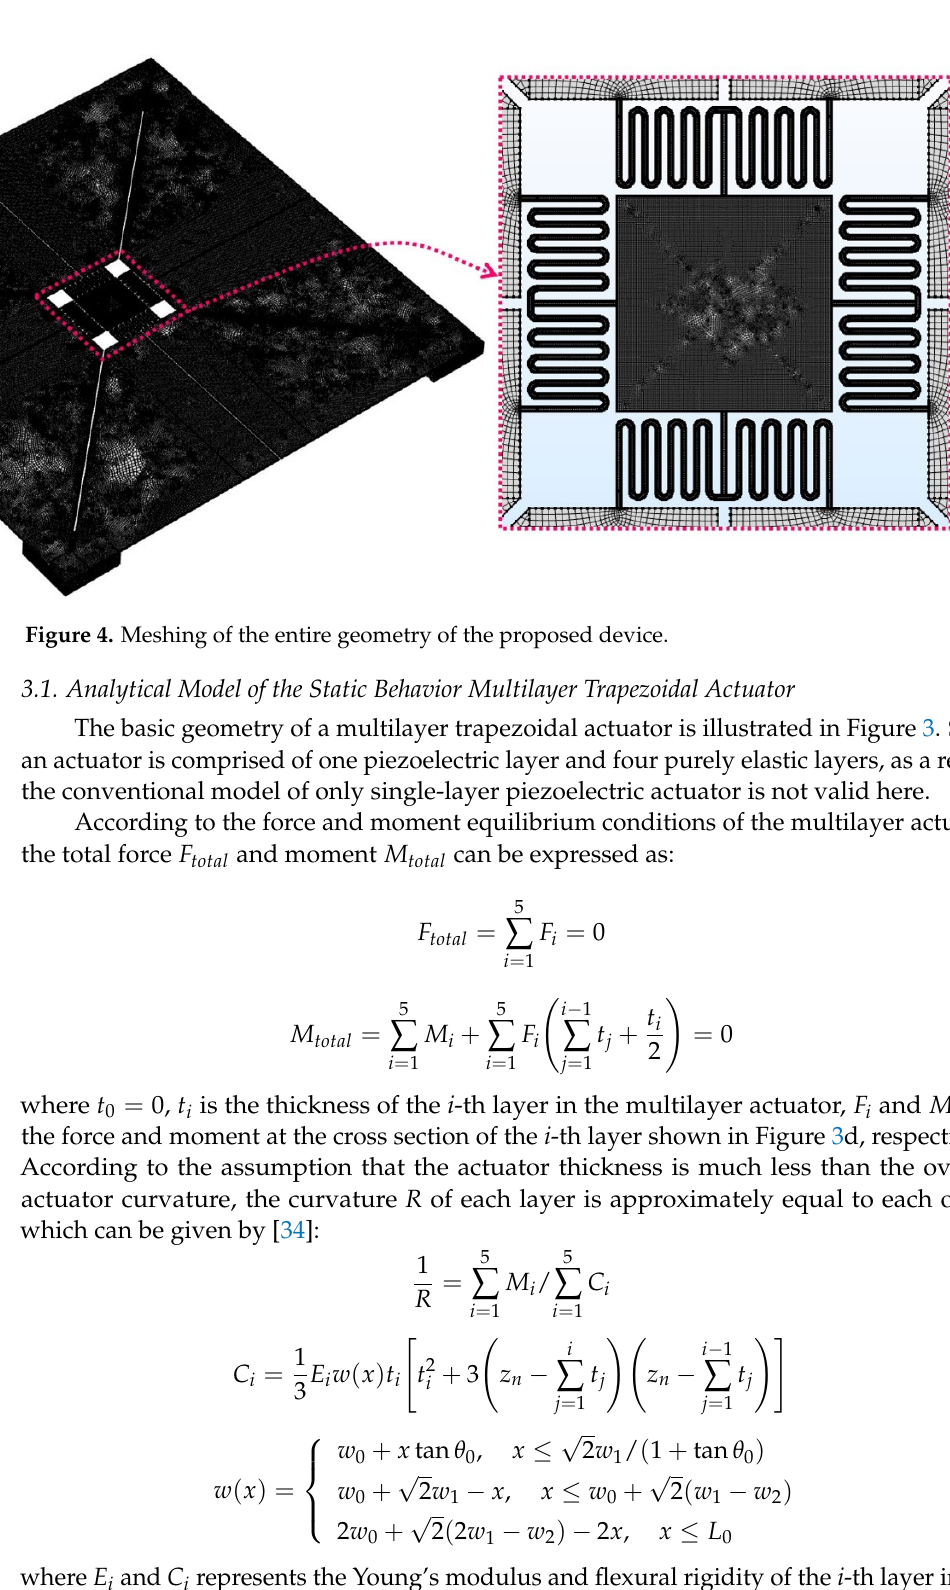
Figure 3. Simplified structural model of the trapezoidal Sc x Al 1-x N based actuators: ( a ) structure configuration of the MEMS mirror, ( b ) top view of the PM actuator, ( c ) design schematic of the meandering spring, ( d ) cross-sectional view of the PM actuator, ( e ) simplification of the MEMS mirror.